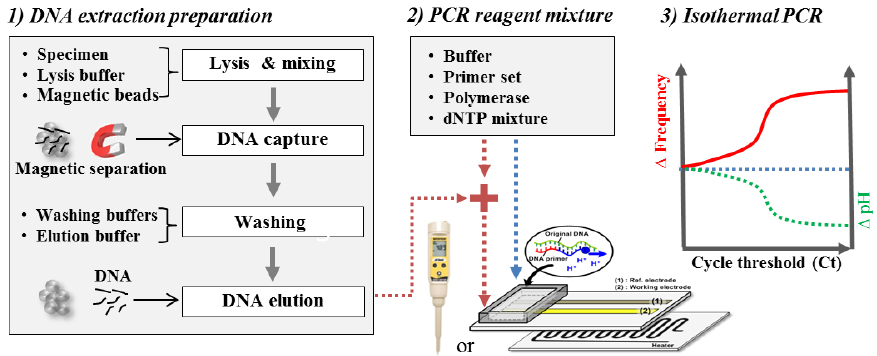
Figure 5. Schematic diagram of the experimental procedures.